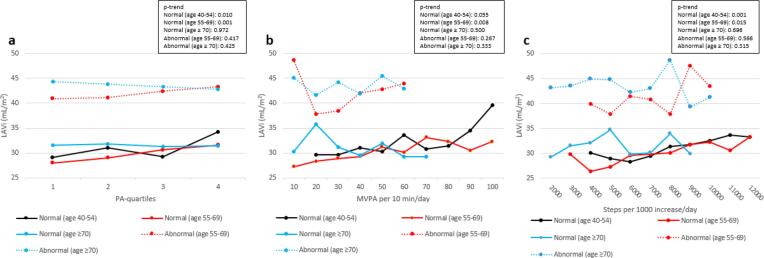
Adjusted mean LAVi stratified by LV diastolic function, age and PA. Fig. 2a show mean LAVi for the PA-quartiles, where quartile 1 is least active and quartile 4 most active. Fig. 2b show mean LAVi for every 10 min increase in MVPA per day, and Fig. 2c show mean LAVi for every 1000 steps per day increase. Mean values were adjusted for PA level, sex, BMI, systolic blood pressure, diabetes, smoking, and LDL cholesterol. LAVi: left atrial volume index, PA: physical activity, MVPA: moderate-to-vigorous physical activity, BMI: body mass index, LDL: low-density lipoprotein. The Tromsø Study 2015–16.